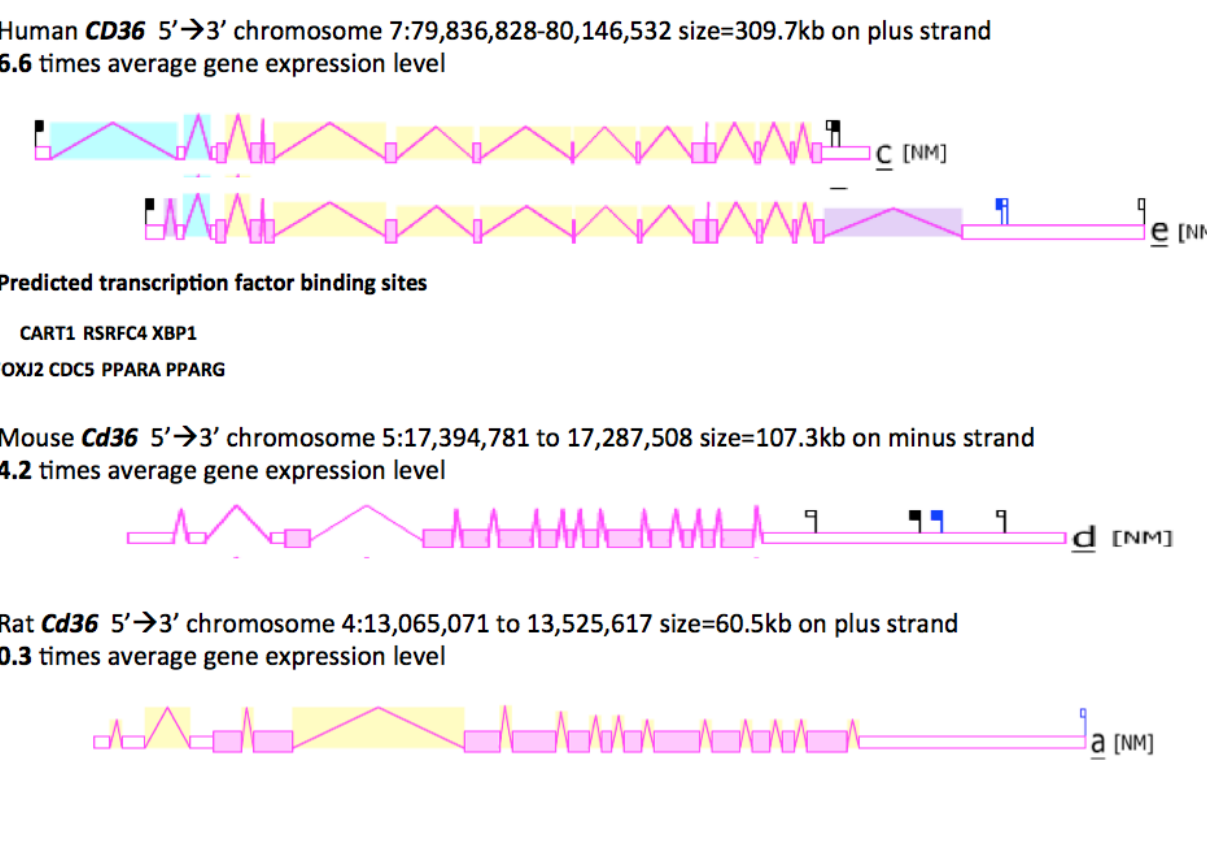
Figure 3. Gene Structures and Major Splicing Transcripts for the Human, Mouse and Rat CD36 Genes. Derived from the AceView